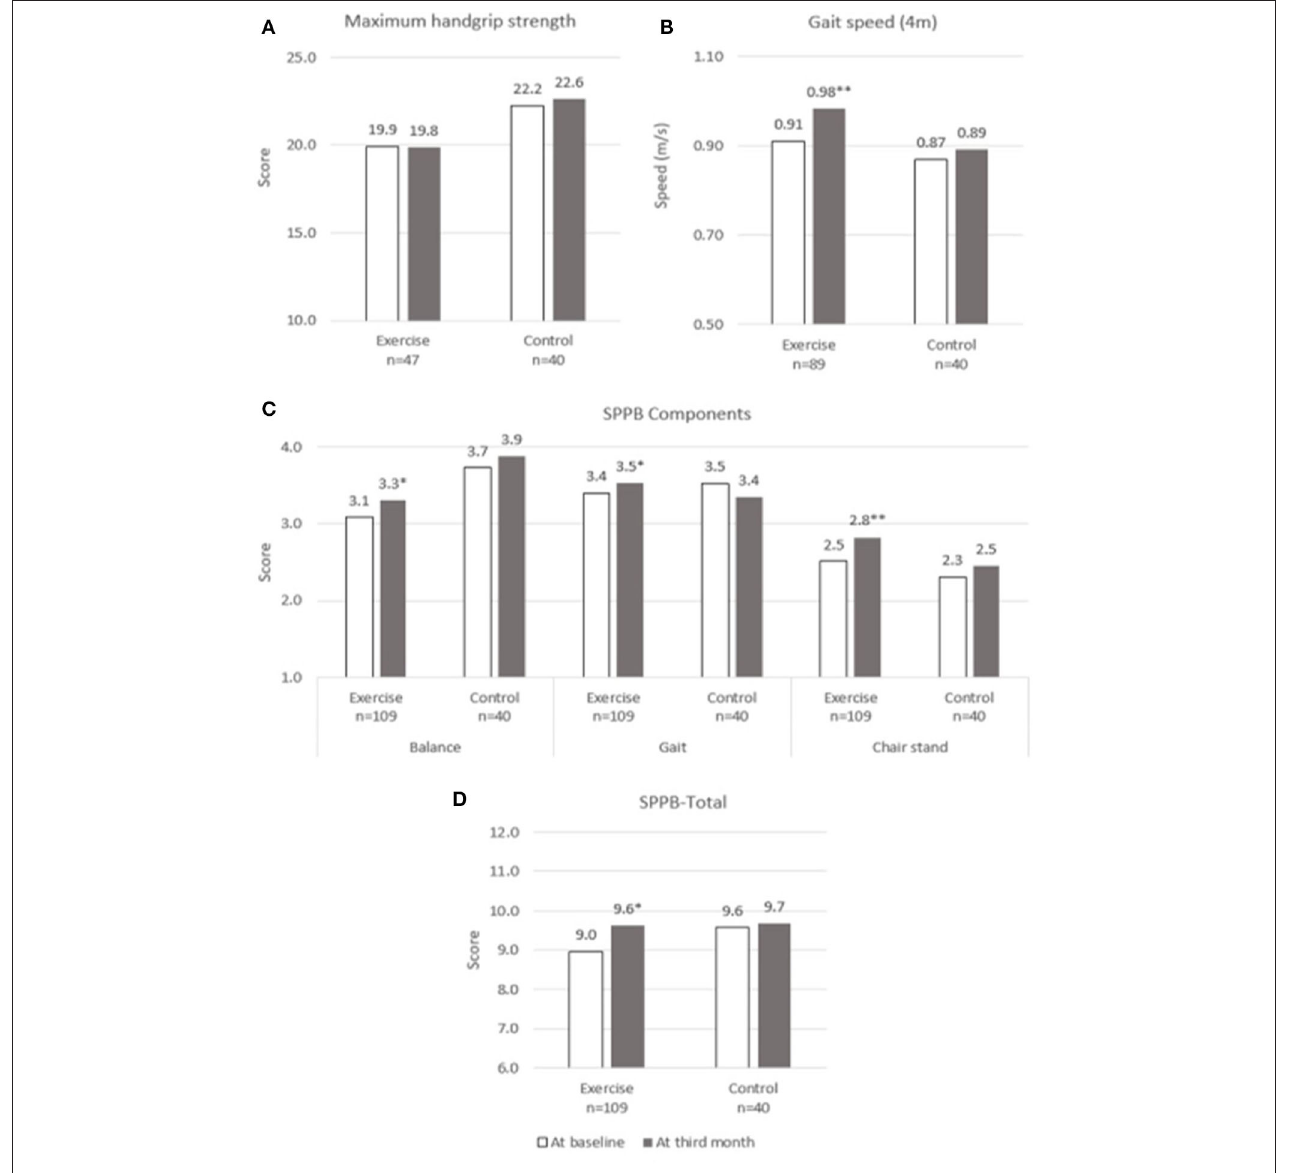
FIGURE 2 | Physical performance at baseline and third month. (A) Maximum Handgrip Strength, (B) Gait speed, (C) SPPB Components, (D) SPPB-Total. SPPB, short physical performance battery. * and **indicate significant difference at p < 0.05 and p < 0.01, respectively between baseline and third month using paired sample t